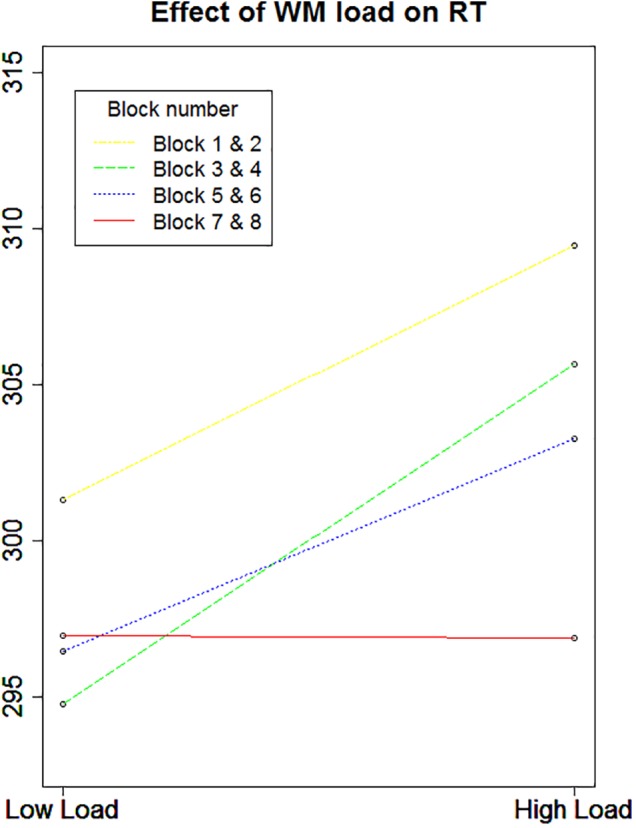
Average RTs as a function of block and load (Experiment 1). A significant interaction between WM load and block (p = 0.012) emerged. Since the load conditions alternated, we chose to look at the blocks in pairs and as such a low and a high WM load block are always coupled. Results show that the effect of WM load on RT decreases over time and even completely disappears in the last two blocks. As a consequence, it seems difficult to assume that the load manipulation was still effective at that time point.